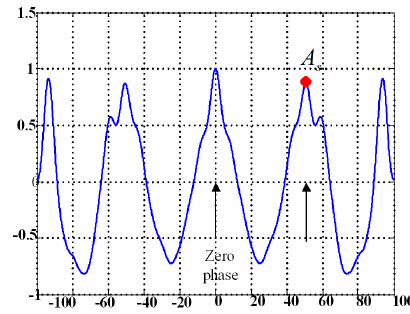
Figure 4. An example of an unbiased autocorrelation sequence of AP-W acceleration signals during walking.